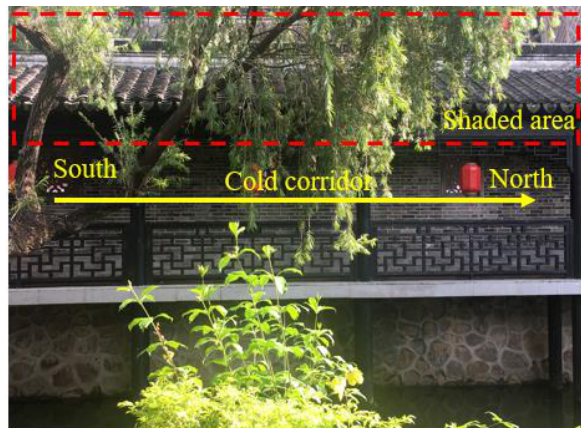
Figure 8. Cold corridor of Zhan Garden in Zhongshan.